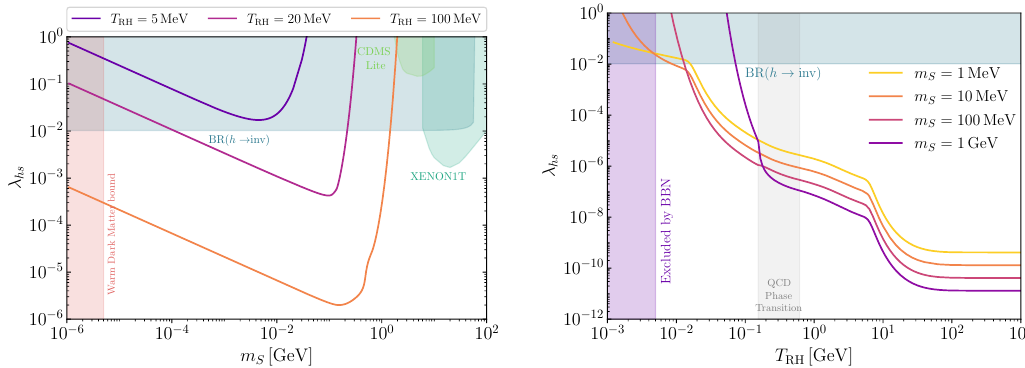
Figure 7 . Left: value of the portal coupling λ hs that leads to the observed DM relic abundance as a function of the singlet mass m S and for different low reheating temperatures T RH . In addition we show bounds from direct detection experiments [75, 76], the LHC [77] and the Lyman- α forest [68, 70]. See text for details. Right: value of the portal coupling plotted as a function of the reheating temperature, T RH , for different singlet masses. T RH < 5 MeV (shown in purple) is excluded by BBN [73]. The grey band corresponds to the temperature range we consider for the QCD phase transition. See text for